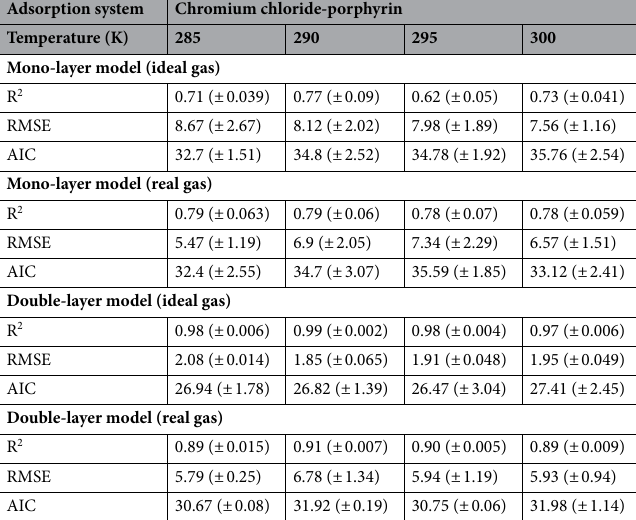
Table 4. Values of the correlation coefficient R 2 , the residual root mean square coefficient RMSE and the Akaike information criterion AIC deduced from the numerical adjustment of experimental isotherms of CrCl 2 on 5,10,15,20-tetrakis(4-methylphenyl) porphyrin with the statistical physics